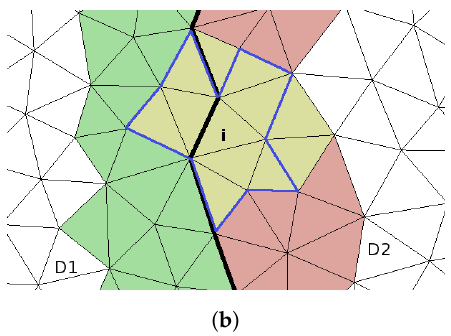
Figure 3. Stencil collection algorithm at processor boundaries. ( a ) Local stencil; ( b ) global stencil. In green, cells of processor D 1 ; in red, cells of processor D 2 ; in yellow, final